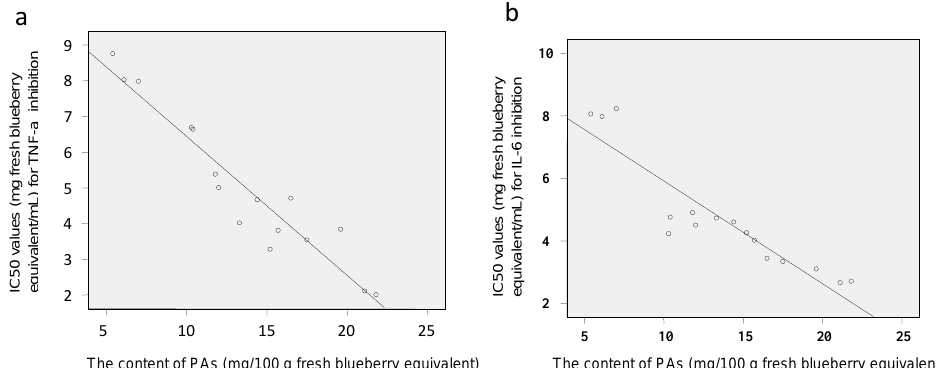
Figure 6. Pearson’s correlation between PAs contents and IC 50 values of the 16 blueberry polyphenol fractions against inflammation, TNF-α ( a ) and IL-6 ( b ) (Pearson’s correlation coefficients ( r ) were - 0.953 ( a ) and -0.916 ( b ), respectively, significance for both at p = 0).